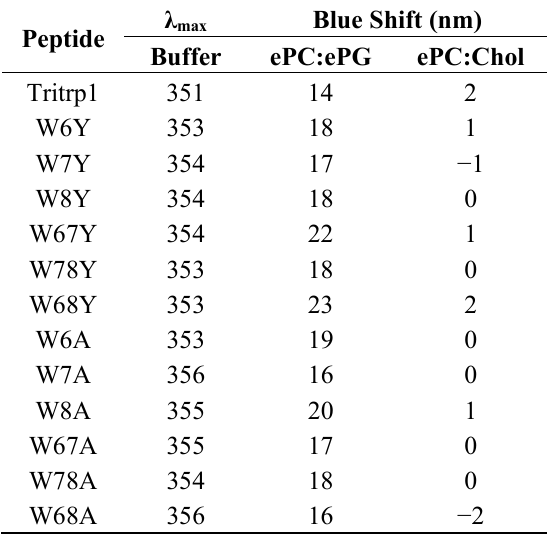
Table 2. Maximum emission wavelengths ( λ max ) in buffer and blue shifts (nm) of the Trp-substituted Tritrp1 analogs upon binding to large unilamellar vesicles (LUVs). ePC, egg-yolk phosphatidylcholine; ePG, egg-yolk phosphatidylglycerol; and Chol, cholesterol. λ max Blue Shift (nm) Peptide